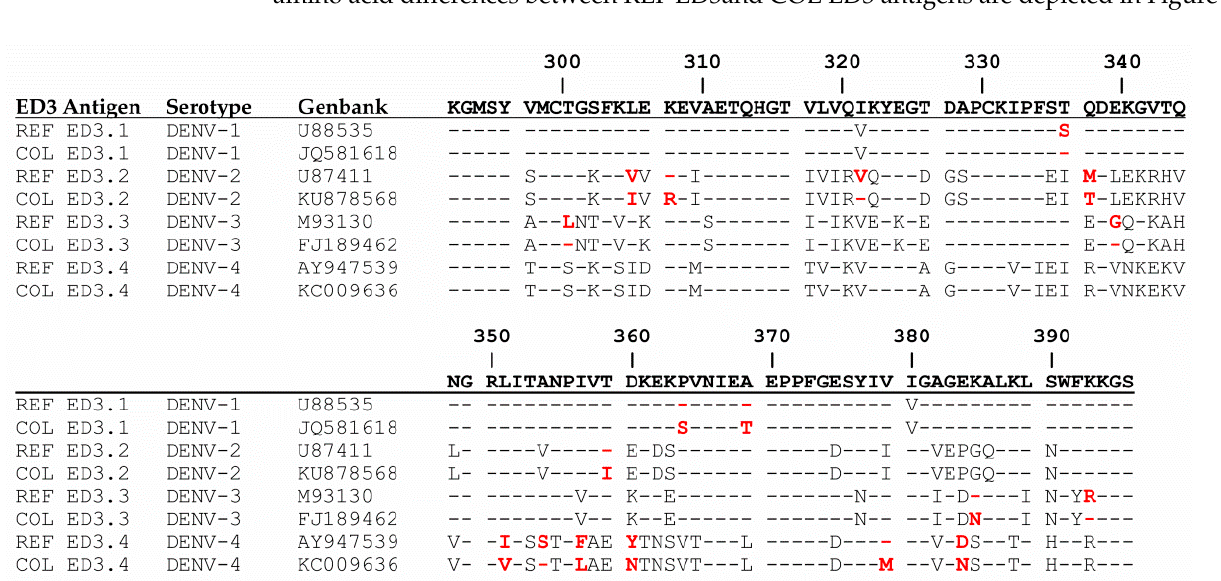
11 of 19 Figure 2. Neutralization of DENV ‐ 1–4 reference strains by paired serum samples. Sera were collected from Colombian